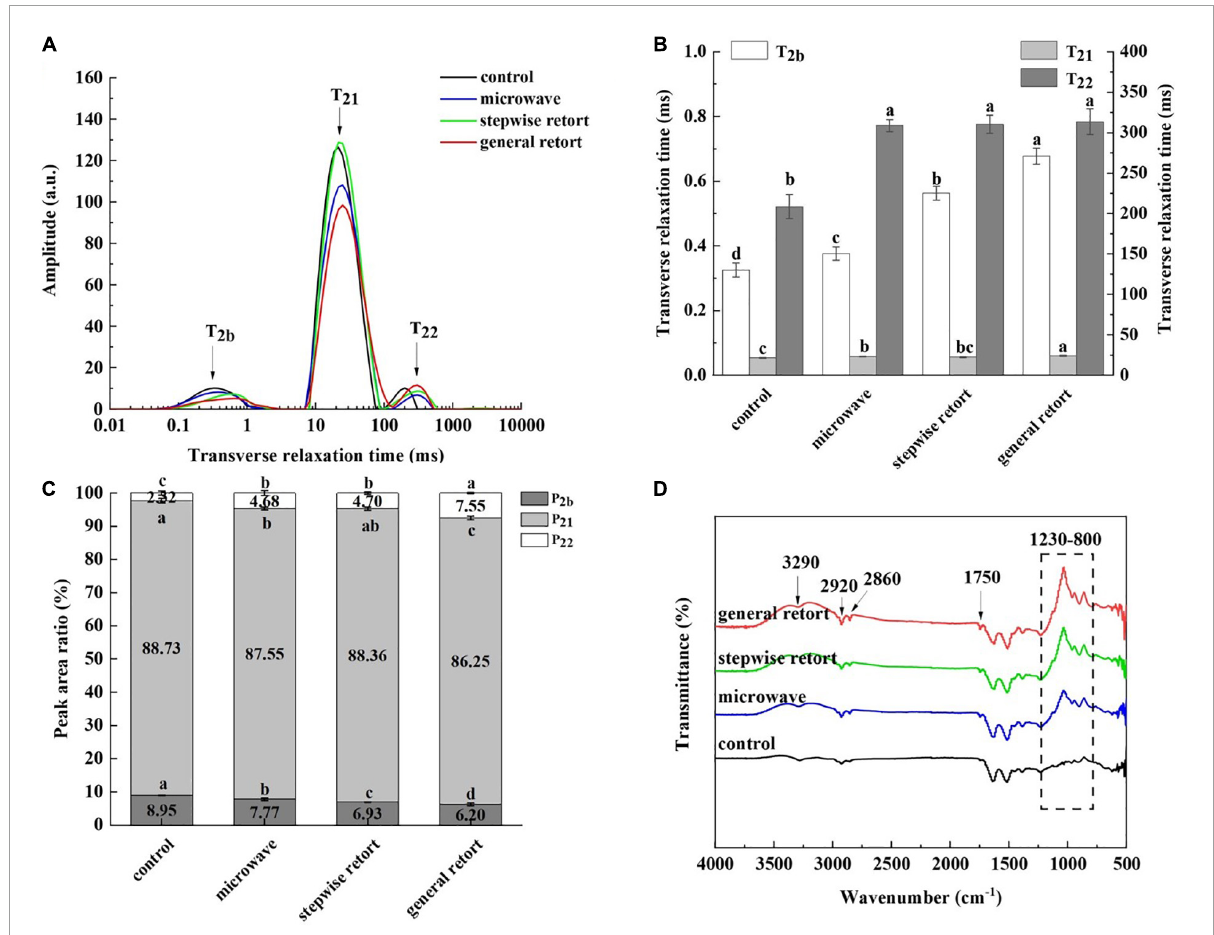
FIGURE2 Distribution spectra (A) , transverse relaxation time T 2 (B) , and peak area ratio (C) of water populations and FTIR spectroscopy analysis (D) for duck meat treated with no thermal sterilization and three sterilization strategies. Different lowercase letters (a–d) represent significant differences between different groups ( P <